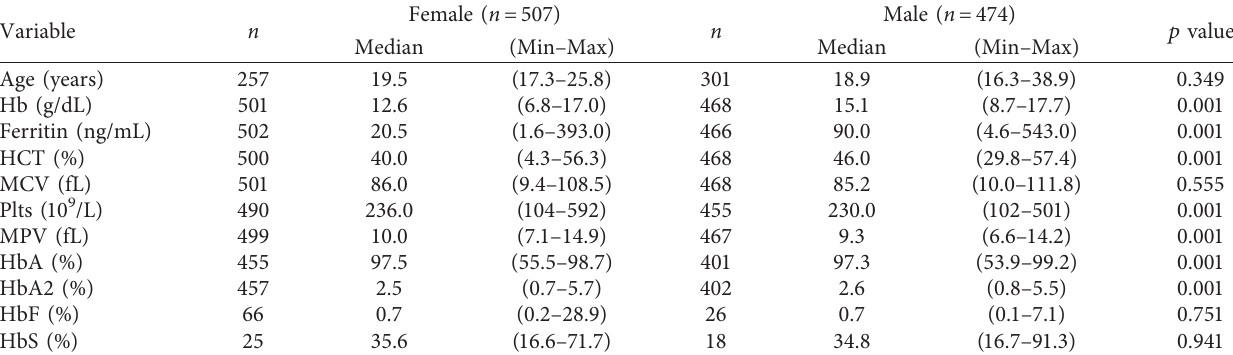
Table 2: Age and hematological profile of the students at the interview.